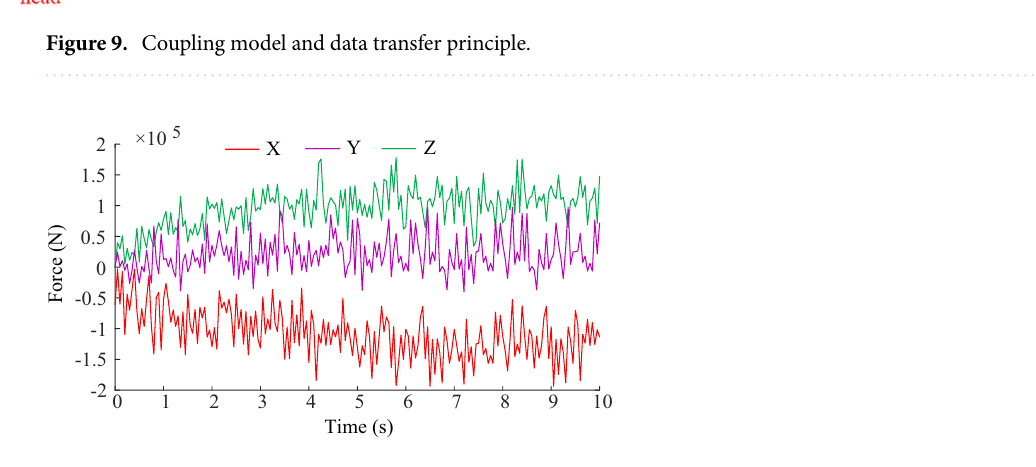
Figure 10. Load curves of the cutting